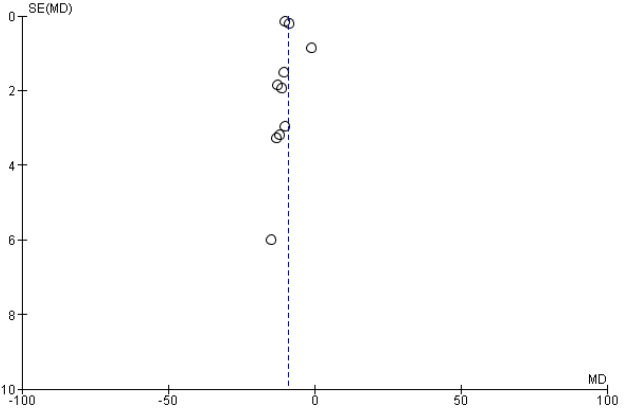
Figure 12. Funnel plot to visualize publication bias. The dots represent the studies distributed around the central line. These help in assessing their distribution and inspecting for publication bias.